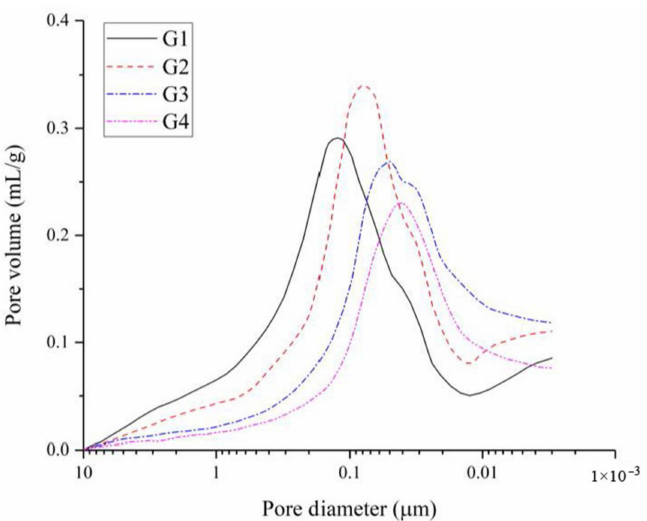
Figure 16. Pore size distribution of hardened slurry (G1, G2, G3, G4) at 7